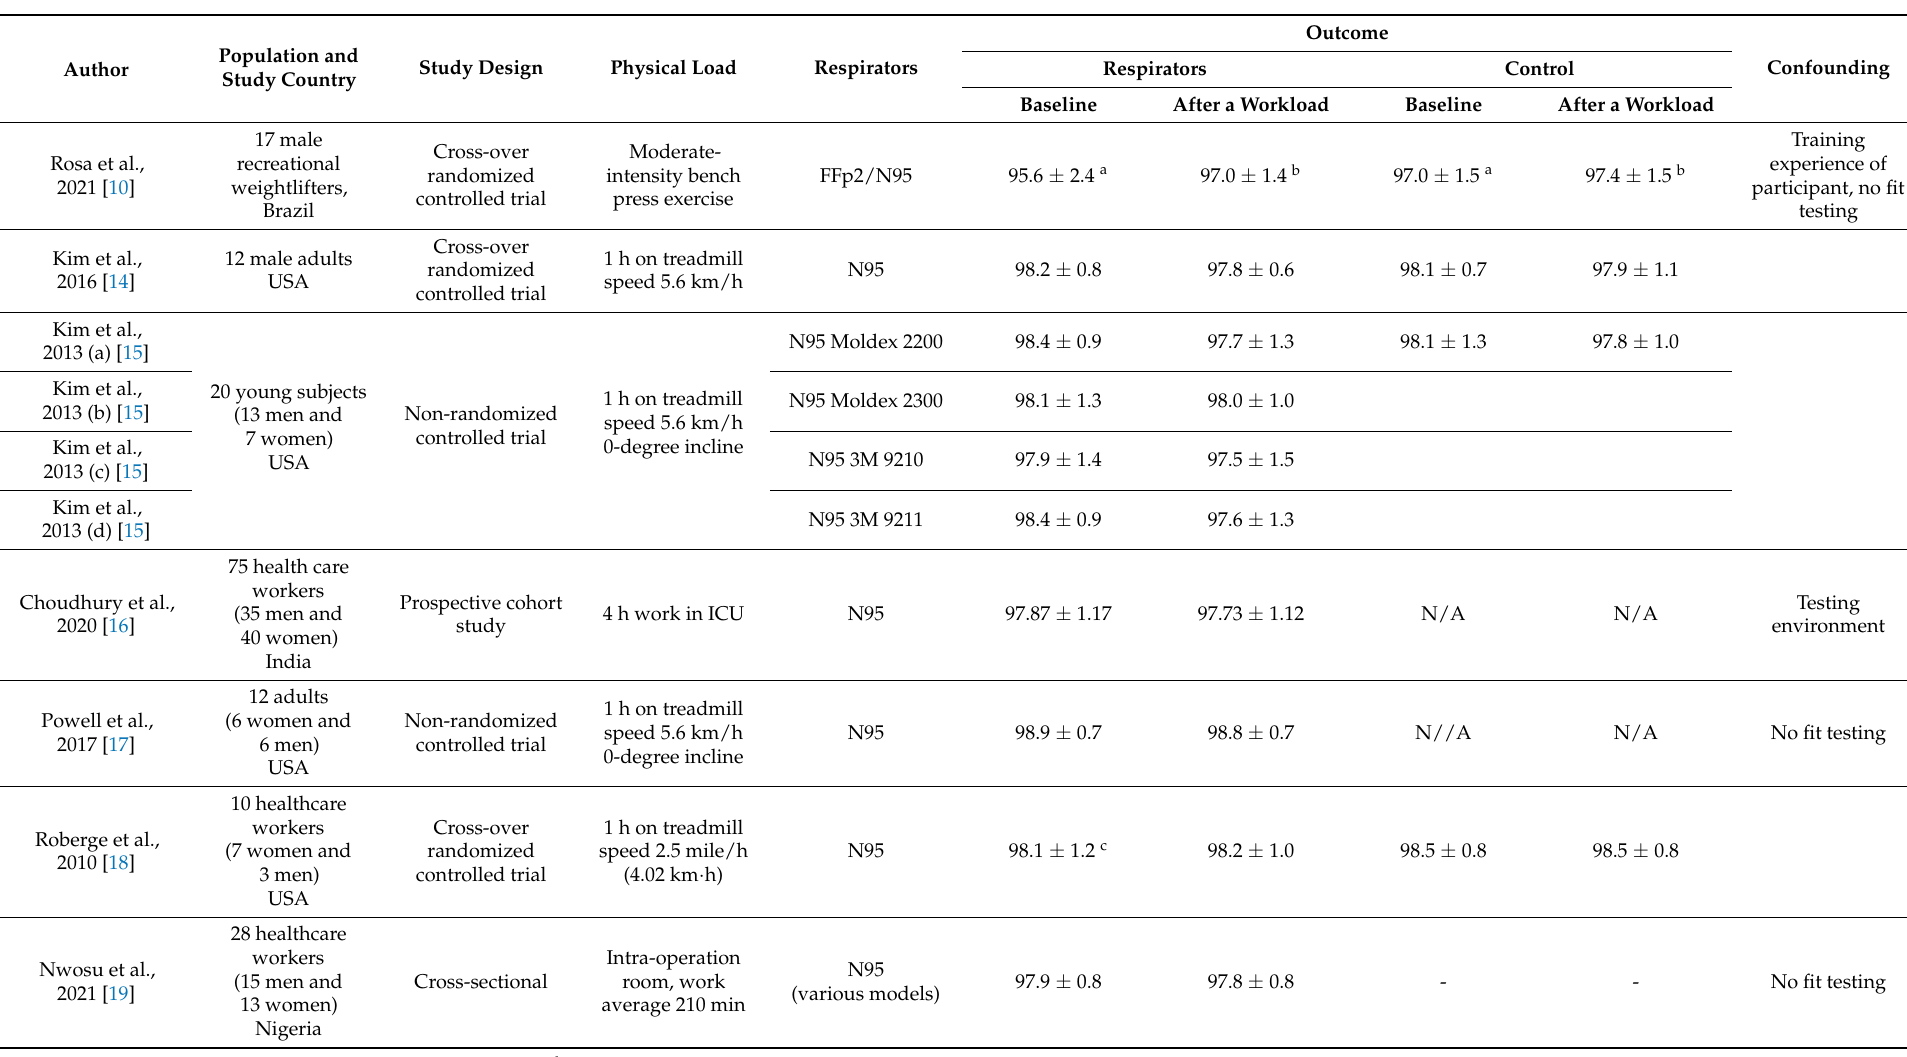
Table 2. Oxygen Saturation in Low-Moderate Physical